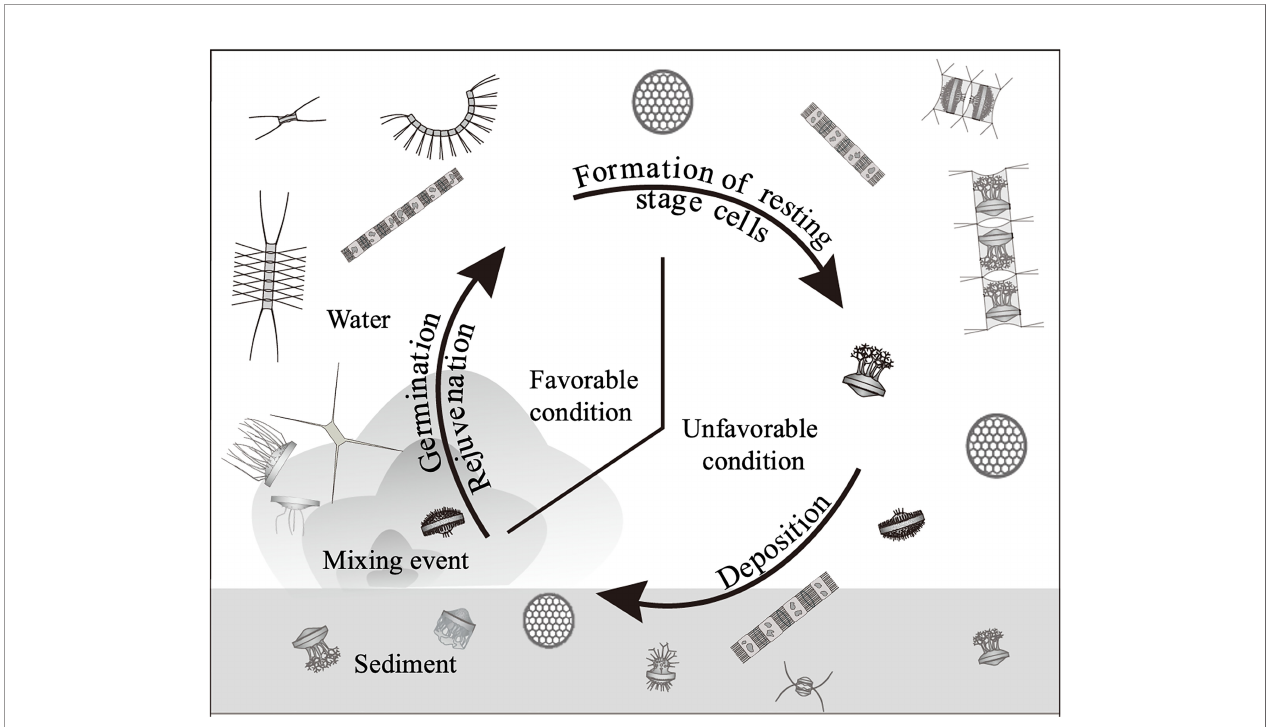
FIGURE 1 | Conceptual diagram of life cycle of the centric diatoms forming the resting stage cells (resting spores and resting